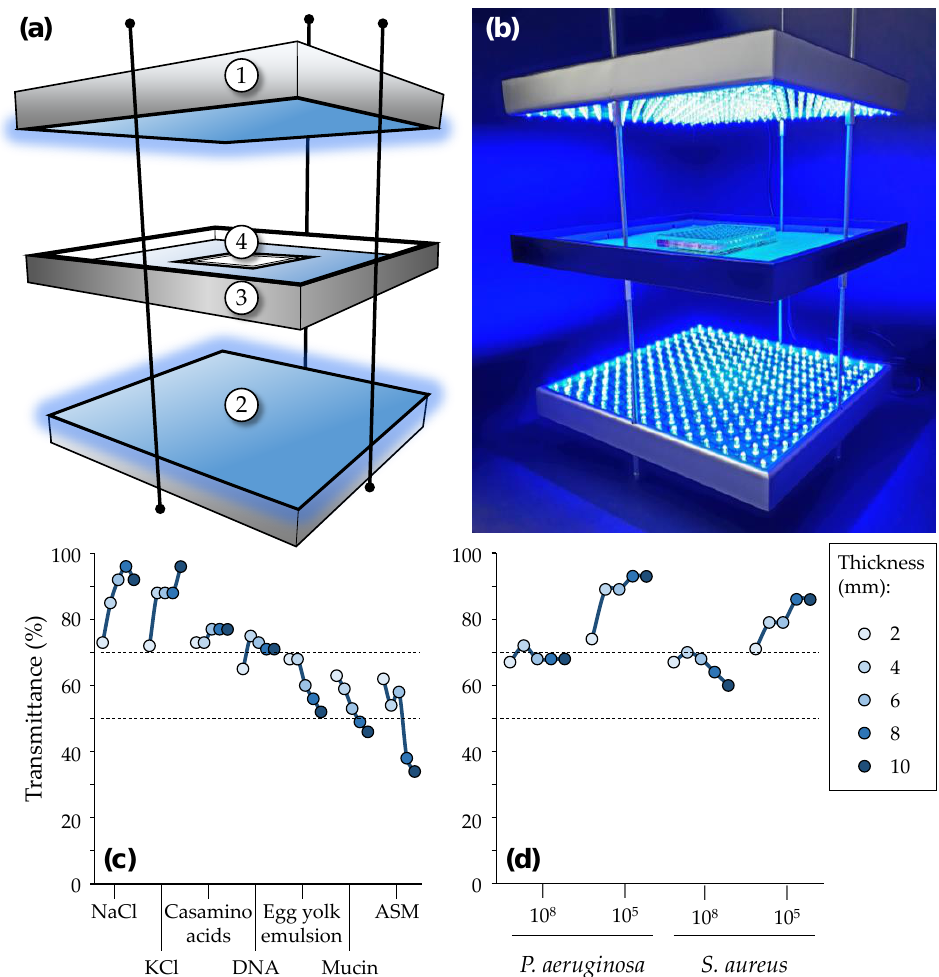
Figure 2. Illumination set-up. Schematic representation ( a ) showing the two LED panels ( ① and ② ) placed above and underneath an in-between plate ( ③ ) used to hold materials placed in a central exposure area ( ④ ). The picture in ( b ) shows the illumination of a 96-well plate containing [Ru(II)] samples. Fluorescence was clearly visible to the naked eyes. Light transmittances was measured through various samples with increasing thicknesses, including ASM and its individual components ( c ) as well as several bacterial inoculums prepared in saline ( d ). The dashed lines correspond to 50 and 70% transmittances, respectively. See Figure S1 for more technical details about this setup.